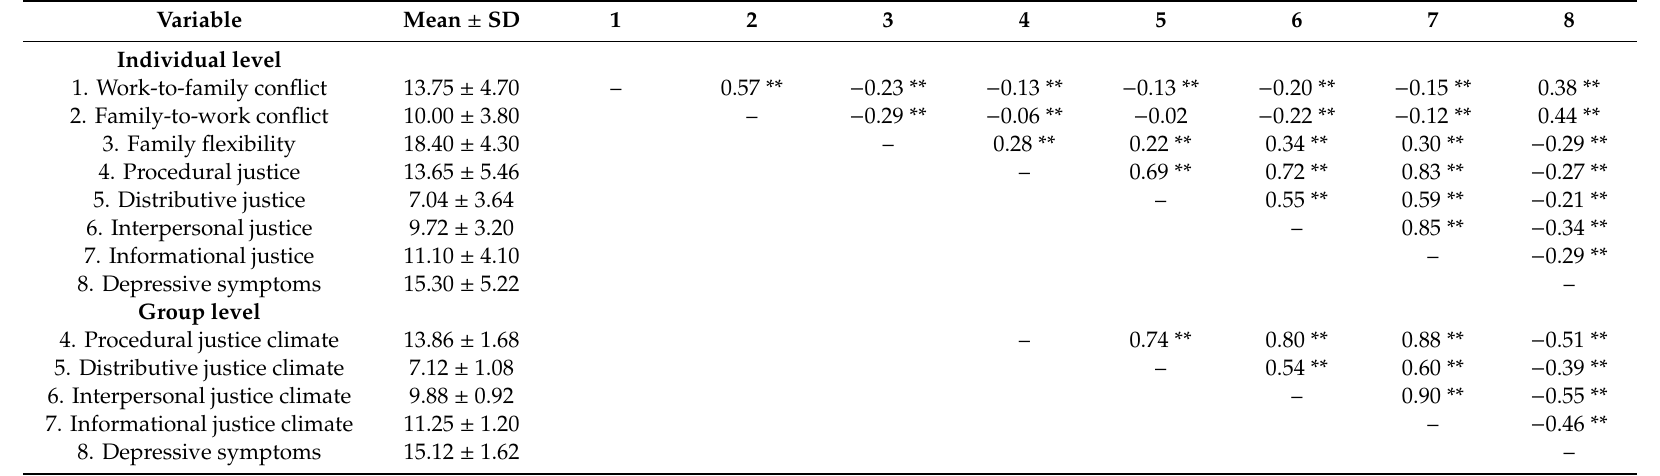
Table 2. Descriptive statistics and bivariate correlations of the study variables at individual level and group level ( n = 2184).